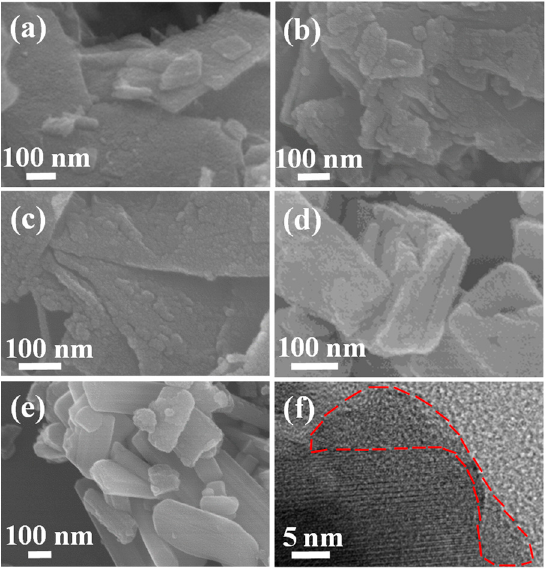
Figure 3. SEM images of K 4 Nb 6 O 17 -C-400 ( a ), K 4 Nb 6 O 17 -C-600 ( b ), K 4 Nb 6 O 17 -C-800 ( c ), K 4 Nb 6 O 17 -C-900 ( d ), K 4 Nb 6 O 17 -C-1000 ( e ). ( f ) TEM image of K 4 Nb 6 O 17 -C-800.